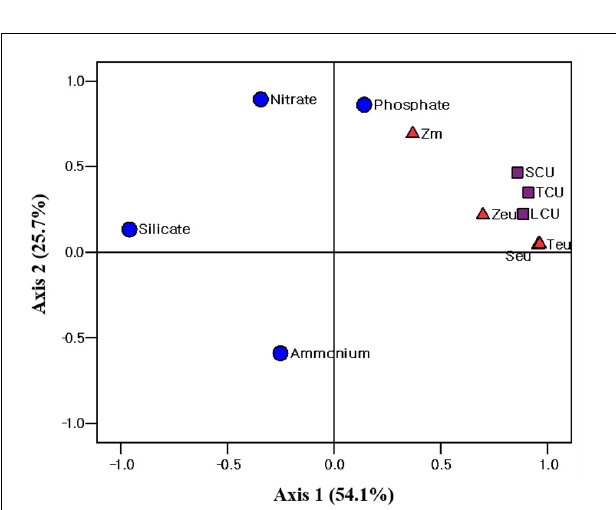
temperature, salinity, and euphotic depth were positively